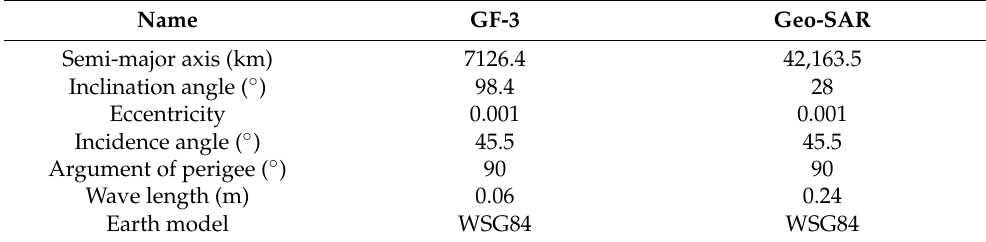
Table 1. Simulation parameters of GF-3 and